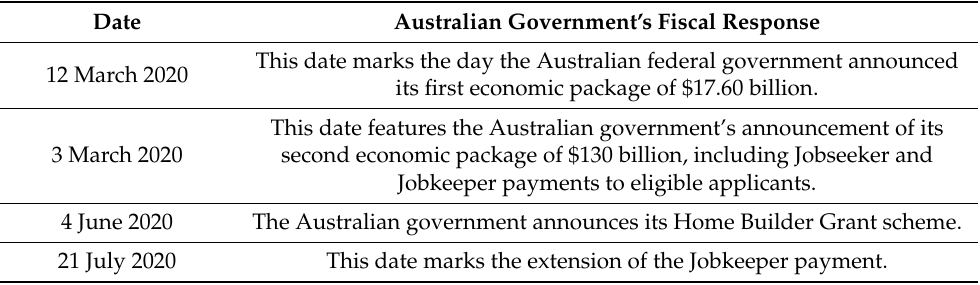
Table 1. Australian government’s economic stimulus in chronological